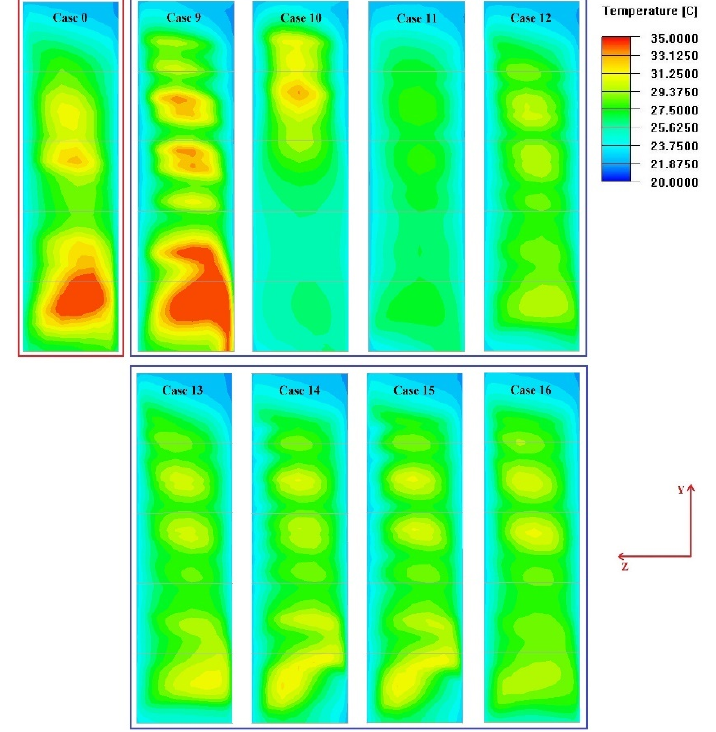
Figure 14. The heat distribution profiles of the air outlet of the rack B4 in case 0 and case 9–16. Table 5. The results of temperature change at different points in cases